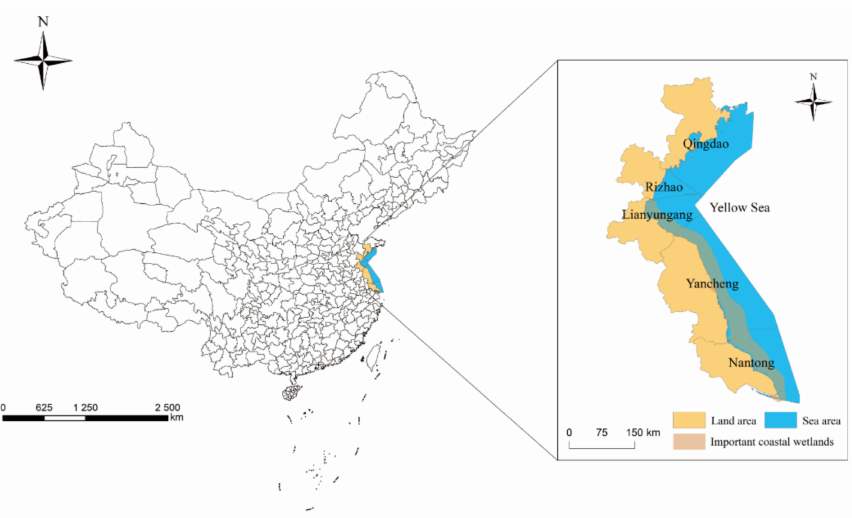
Figure 1. Study area: Five coastal cities on China’s Yellow Sea